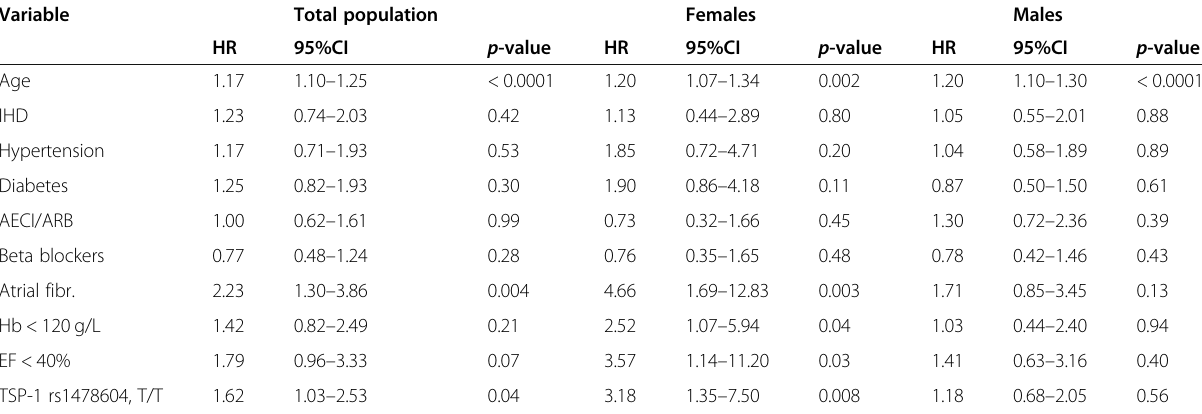
Table 7 Cox proportional hazard regression analysis evaluating risk of cardiovascular mortality regarding rs1478604 of TSP-1 in the study population divided in the total population, and into the two genders Variable Total population